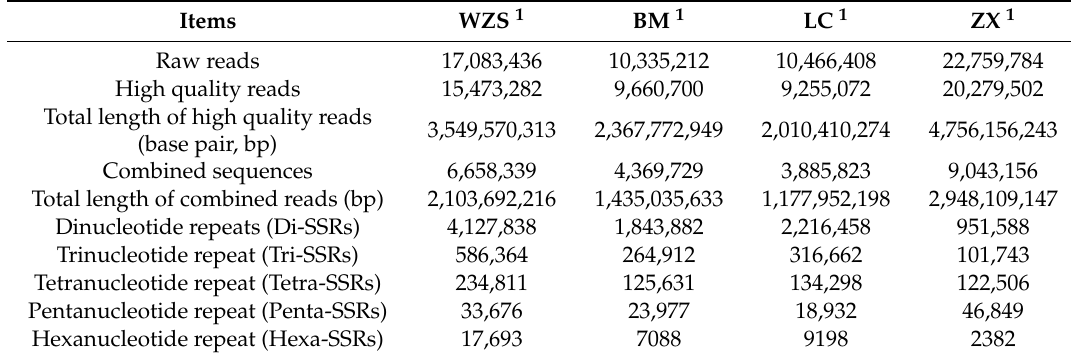
Table 1. Statistics of four datasets and SSRs discovered from four pig breeds.